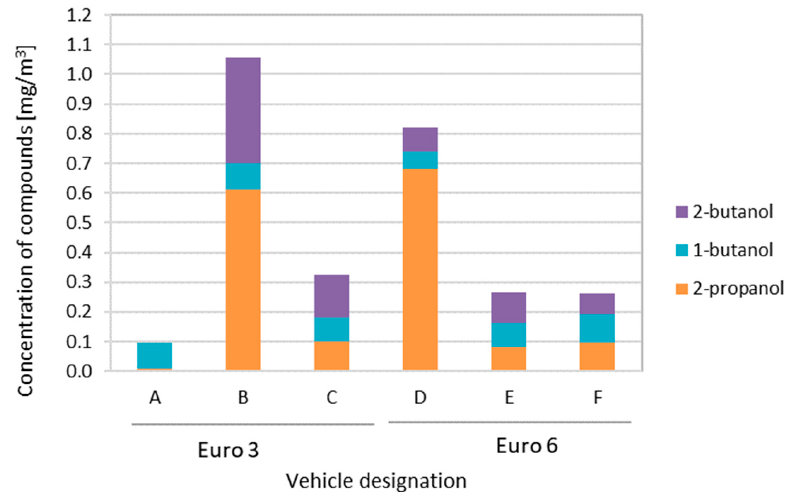
Figure 4. Quantitative assessment of alcohols group. Table 3. PAH concentration in the tested vehicles.